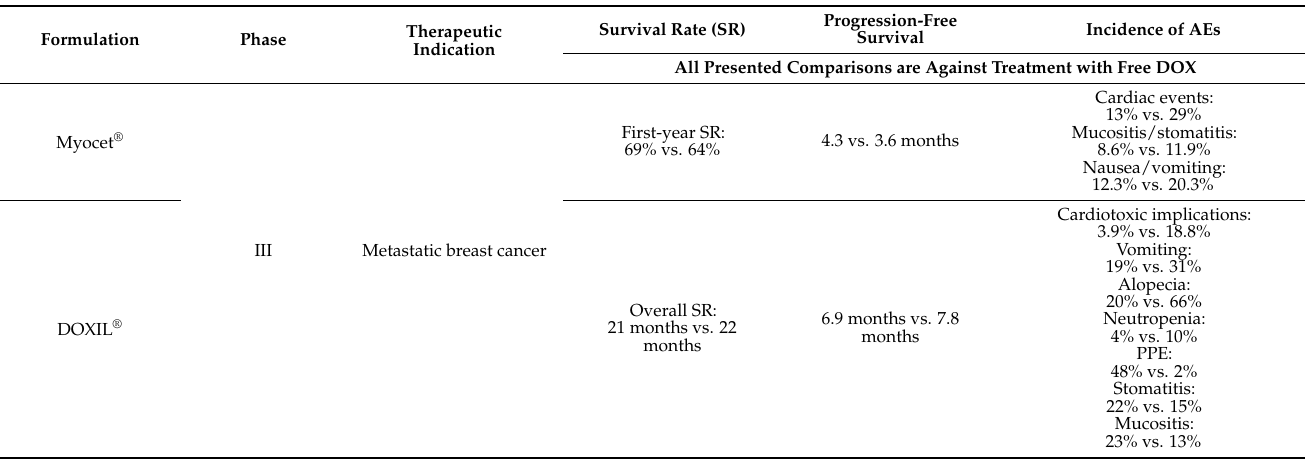
Figure 7. Summary of ROR of conventional, PEGylated, and non-PEGylated liposomal DOX in the FAERS database. (High resolution image at https://doi.org/10.1371/journal.pone.0185654.g002 accessed on 3 January 2022). Adapted from [75], PLOS, 2017. Table 3. Phase III clinical trials findings of treatment with Myocet ® and Doxil ® against free DOX in patients with breast cancer [81–83].